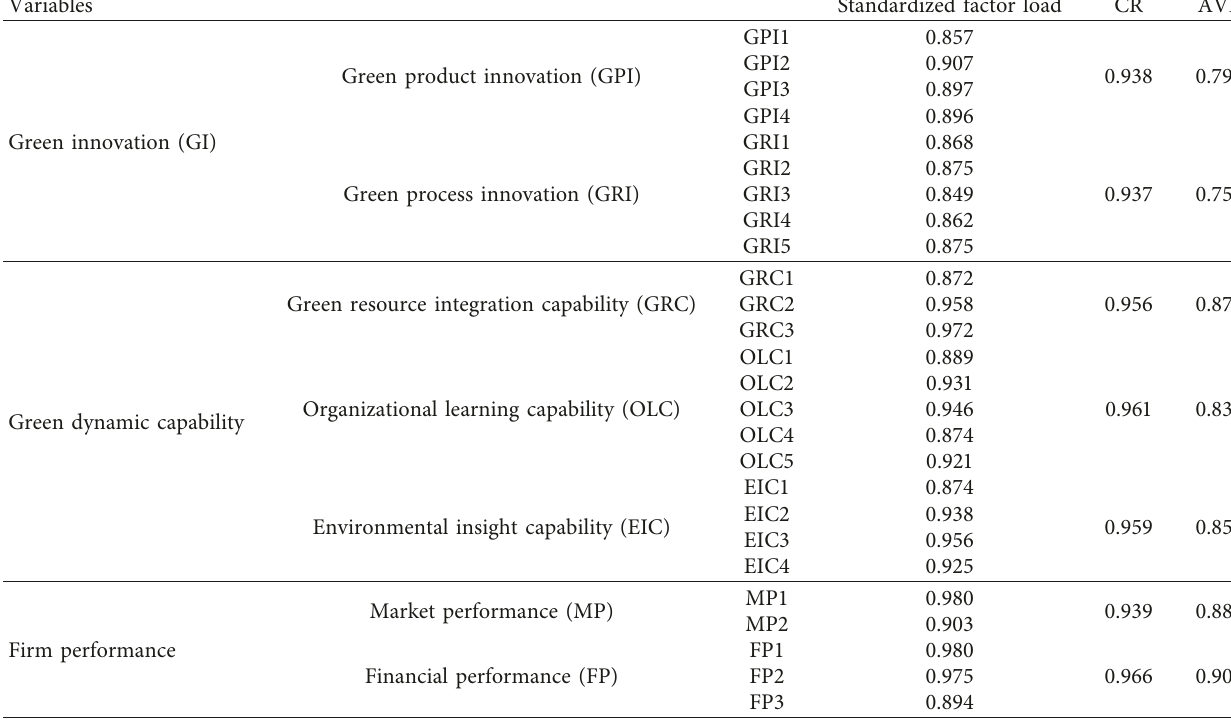
Table 8: The result of convergent validity.